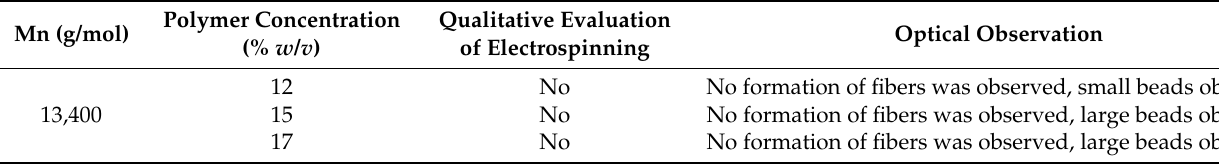
Table 5. Qualitative evaluation of electrospun samples.